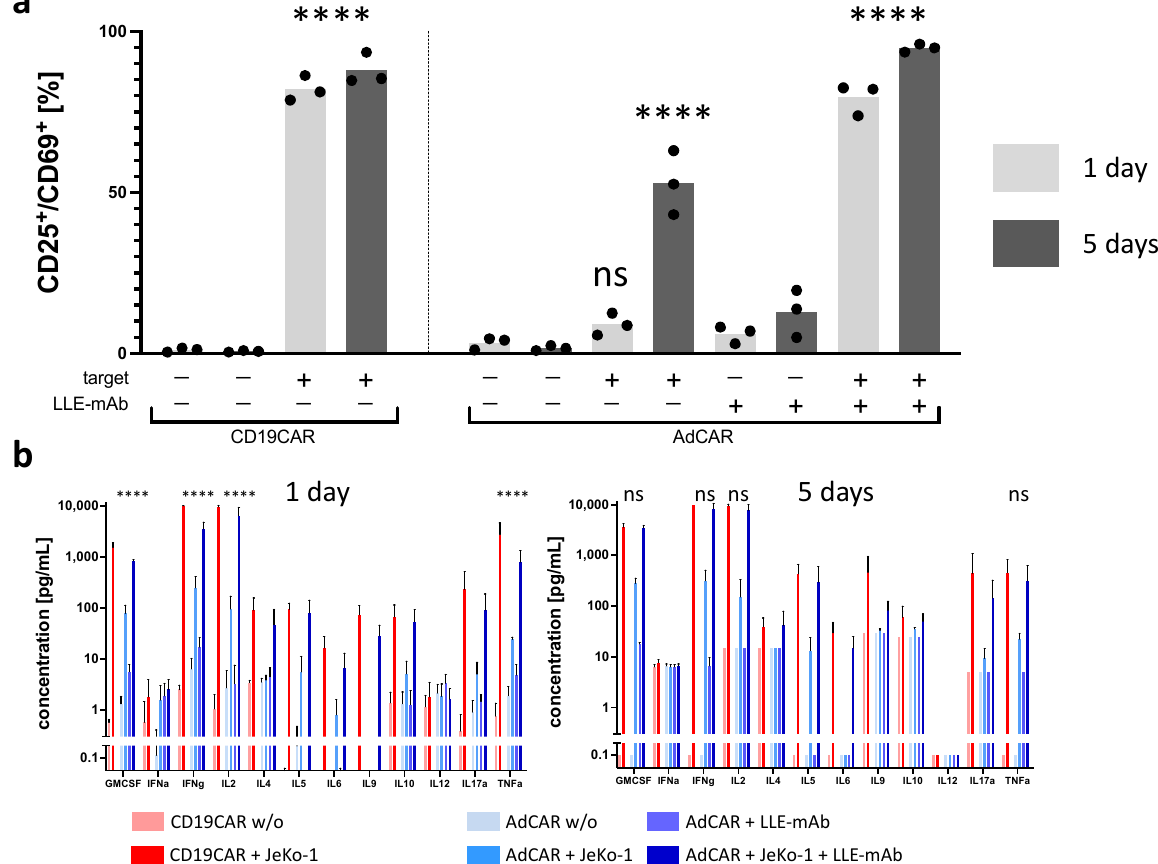
Figure 3. Activation and cytokine secretion profile of AdCAR T cells vs. CD19CAR T cells. ( a ) CD19CAR T cells were incubated for 24 h (light grey) and for 5 days (dark grey) with or without the CD19 + lymphoma cell line JeKo-1. Additionally, AdCAR T cells were incubated for 1 day (light grey) and for 5 days (dark grey) with or without the CD19 + lymphoma cell line JeKo-1, and with or without 10 ng/mL LLE-CD19 mAb. Specific CAR activation after incubation was determined by flow cytometry staining of the cell surface activation markers CD25 and CD69. The double-positive CD25 + CD69 + cells were considered and defined to be the activated cell subset. ( b ) The quantitative levels of the indicated secreted cytokines in the supernatant were measured after 1 day (left) and after 5 days (right). Data shown in ( a ) represent the mean ± SEM of (n = 1) independent experiments from three different donors. Data shown in ( b ) represent the mean ± SEM of (n = 1) independent experiments in duplicate from three different donors. ns, not significant. ****, p ≤ 0.0001. Cytokine secretion was assessed as a secondary indicator of CAR effector function. The cytokine concentrations were measured in the supernatants after 1 day and after 5 days (Figure 3b). The cytokine panel comprised the 12-cytokine multiplex panel: GMCSF, INF α , IFN γ , IL2, IL4, IL5, IL6, IL9, IL10, IL12, IL17a, and TNF α . With regards to the secretion kinetics of the most relevant CAR T cell cytokines GMCSF, IL2, IFN γ , and TNF α , we observed significantly higher cytokine levels secreted by conventional CD19CAR T cells than by AdCAR T cells after 1 day. However, after 5 days, significant differences in the cytokine profile of CD19CAR T cells and AdCAR T cells were no longer detectable. The antigen-specific CAR-mediated cytolysis is illustrated in Figure 4. Antigen-specific CAR activation was further supported by the activation-dependent cytokine secretion, a